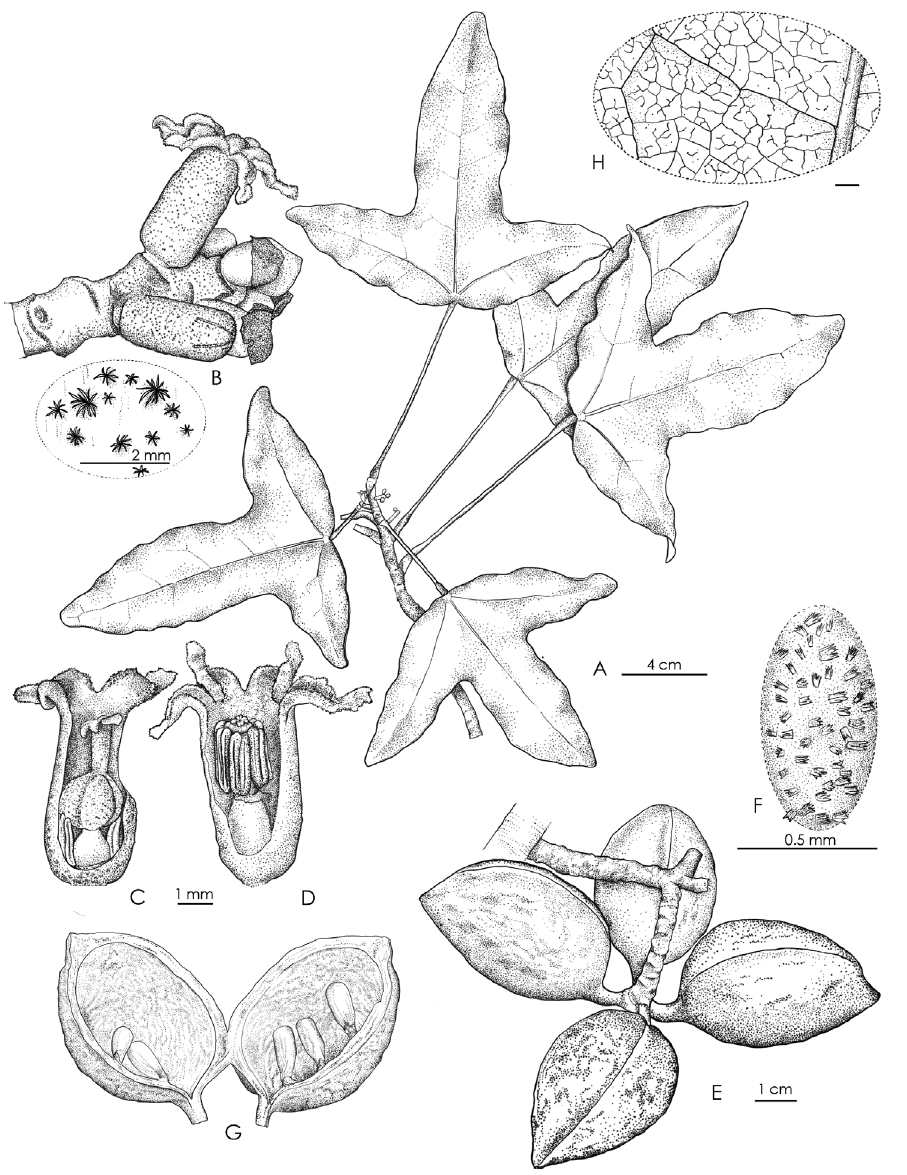
Figure 2. Acropogon horarius Gâteblé & Munzinger sp. nov. A flowering branch B inflorescence and a zoom on stellate trichomes of the flower tube C female flower D male flower E infructescence F detail of erect stellate trichomes on the follicle’s surface G detail of an open follicle H close-up of the abaxial leaf reticulum. Drawings by Laurence Ramon (A–H Gâteblé et al. 806